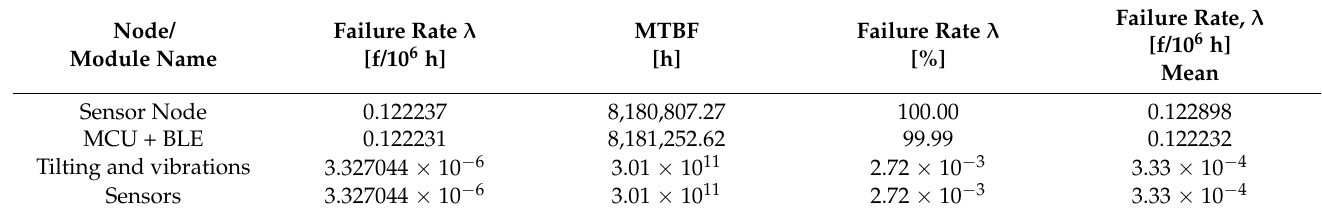
Table 3. Reliability analysis of the sensor node structure considering all the blocks working on demand mode and the device in IDLE mode, in 100% GB at 25 ◦ C.